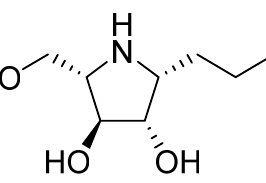
Figure 1. Chemical structure of the iminosugar PDIA.